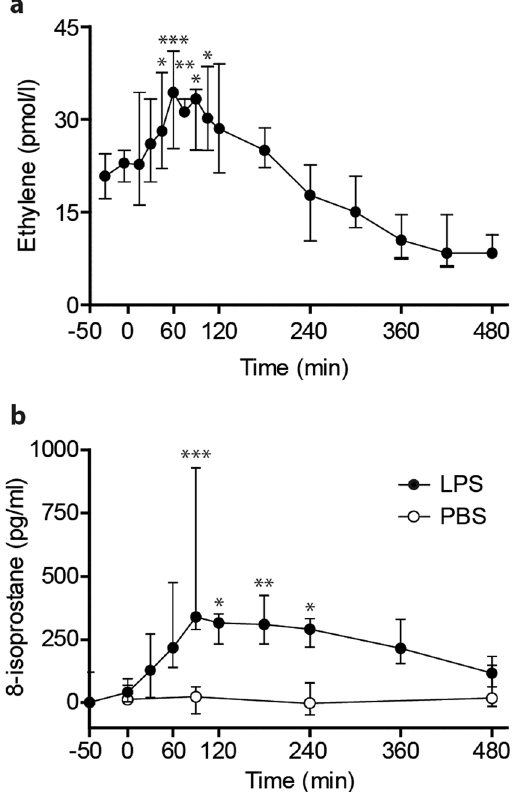
Figure 3. Ethylene and 8-isoprostane release during human endotoxemia. ( a ) Time course of ethylene levels in breath of healthy volunteers after intravenous administration of a single dose of LPS at t = 0. (b) Time course of 8-isoprostane levels as determined by EIA in serum samples of healthy volunteers after intravenous administration of a single dose of LPS (present study, n = 8) or phosphate buffered saline (PBS) (previous study, n = 6) at t = 0. Data points show median with interquartile range, asterisks indicate significance compared to baseline (t = − 30 for ethylene, t = 0/ − 50 for 8-isoprostane